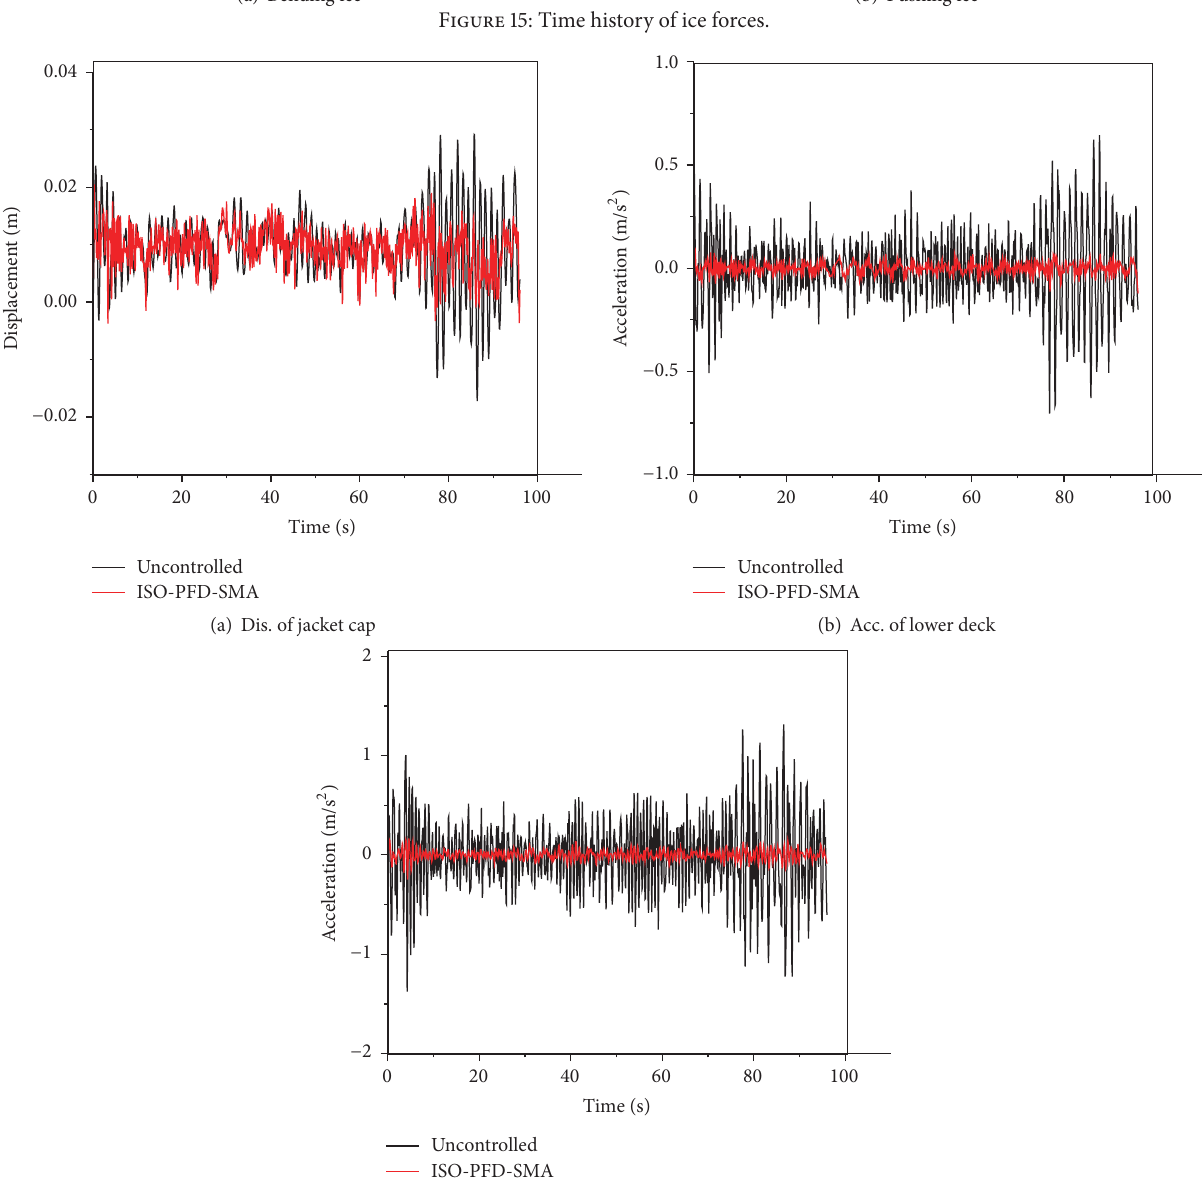
Figure 15: Time history of ice forces.